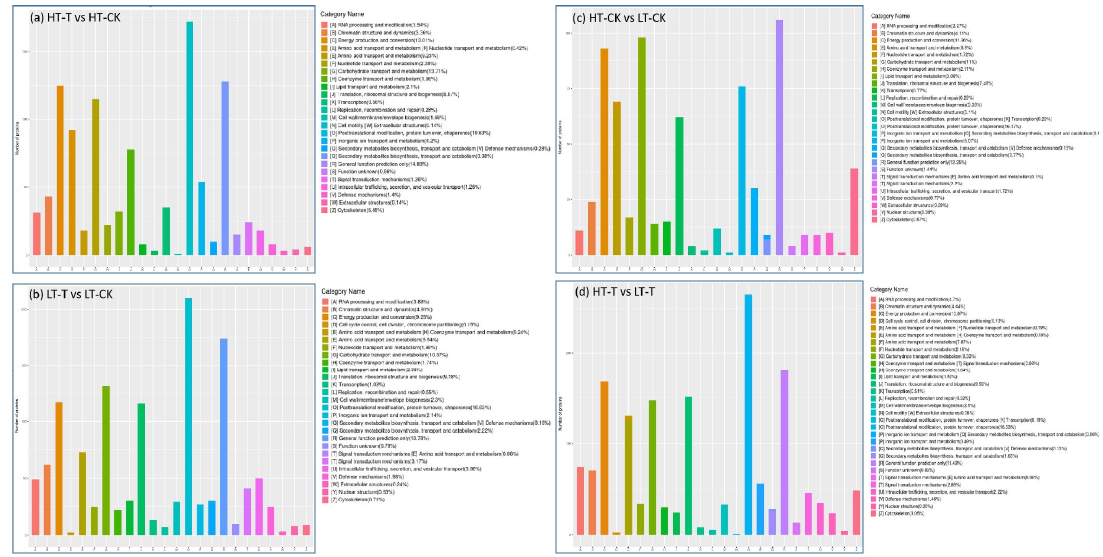
Figure 4. COG functional classification of the differentially abundant proteins. The abscissa is the COG category, while the ordinate is the number of differentially abundant proteins in each category.